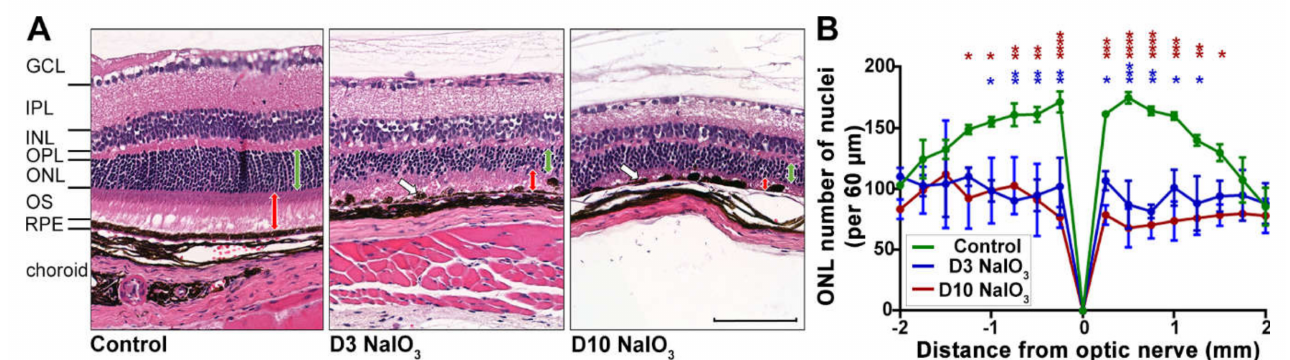
Figure 1. Time course of NaIO 3 -induced retinal degeneration. ( A ) H&E staining of murine retinal cross-sections at three (D3) and ten (D10) days following the NaIO 3 treatment showed a disruption of the RPE layer, clustering of the RPE cells (white arrows) and photoreceptor degeneration. The photoreceptor segments (PS) were reduced at three days and nearly completely missing ten days after the treatment (red arrows), but also, the thickness of the outer nuclear layer (ONL) decreased substantially (green arrows). NFL, nerve fibre layer; GCL, ganglion cell layer; IPL, inner plexiform layer; INL, inner nuclear layer; OPL, outer plexiform layer. Scale bar: 50 µ m. ( B ) The number of photoreceptor nuclei per 60- µ m retinal section was counted to quantify the progress of degeneration. A two-way ANOVA with Bonferroni post-tests showed reduced photoreceptor numbers in treated versus untreated mice (* p < 0.05, ** p < 0.01, *** p < 0.001 and **** p <